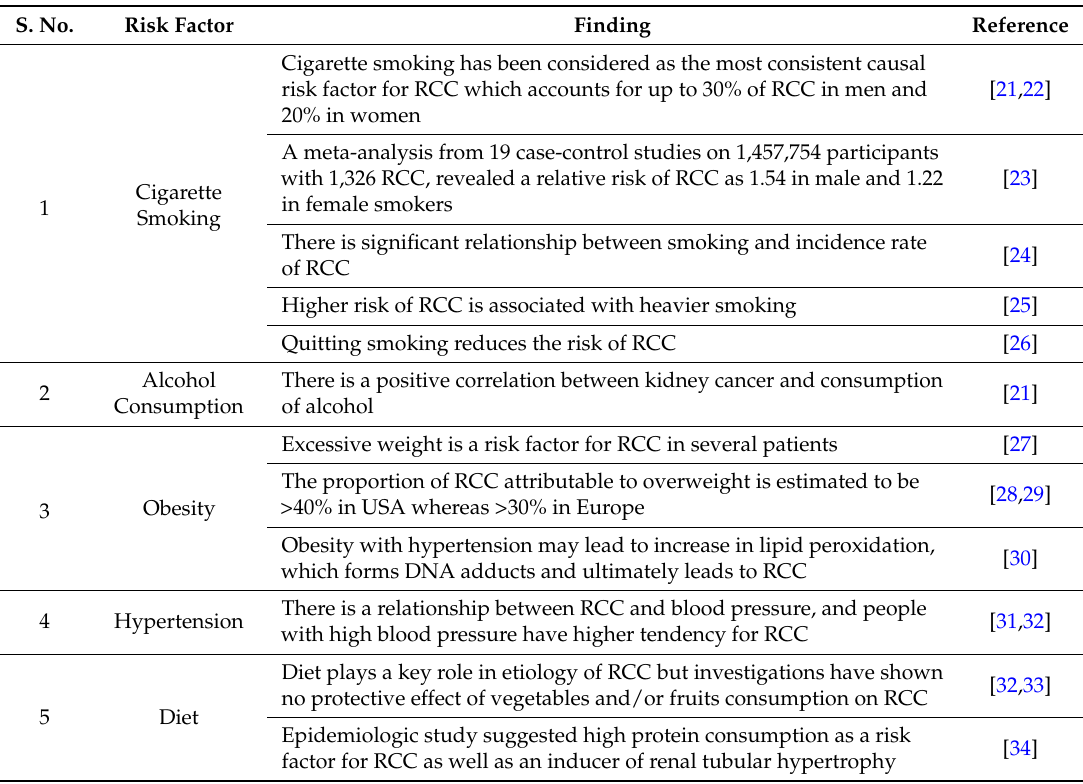
Table 1. Possible risk factors and their role in renal cell carcinoma